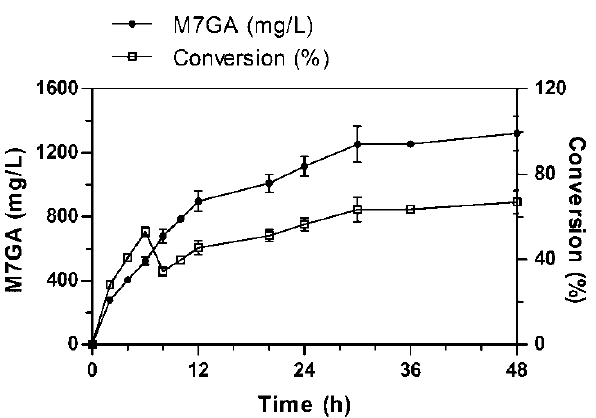
Figure 4. Time course for the production and conversion of myricetin-7- O -glucuronide (M7GA) obtained in a 3-L fermenter system containing 1 L of whole-cell catalyst. Two volumes of 20 mL myricetin stock solution (100 mM, dissolved in DMSO) was supplied in the reaction system at 0 h and 6 h, respectively.